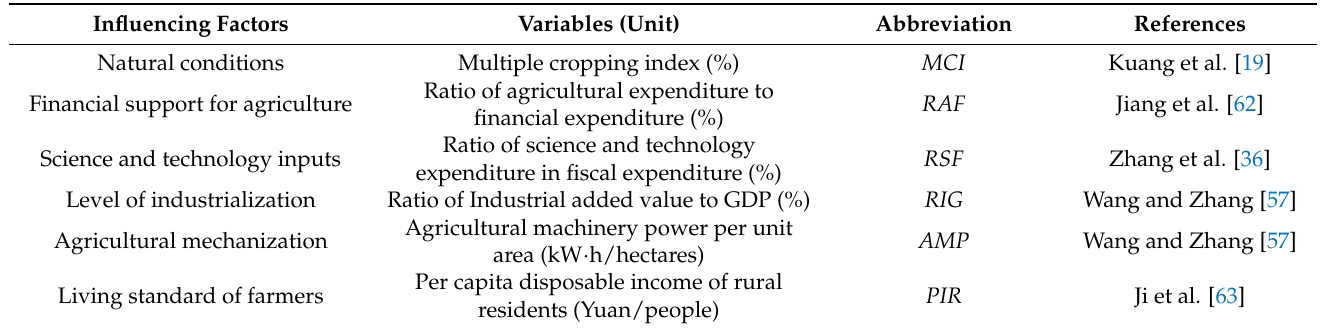
Table 4. Description of influencing factor